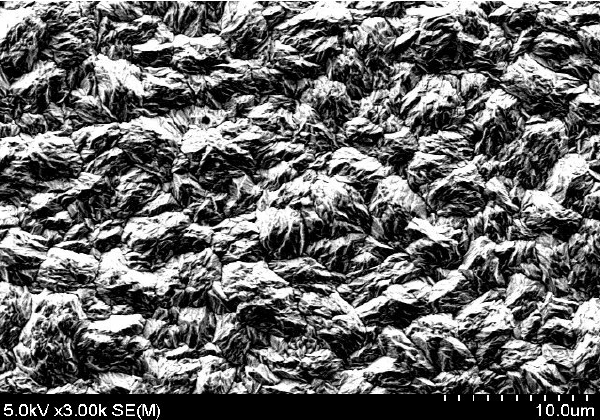
Figure 10. SEM image of Bi 2 Te 3 film surface formed by pulsed deposition.